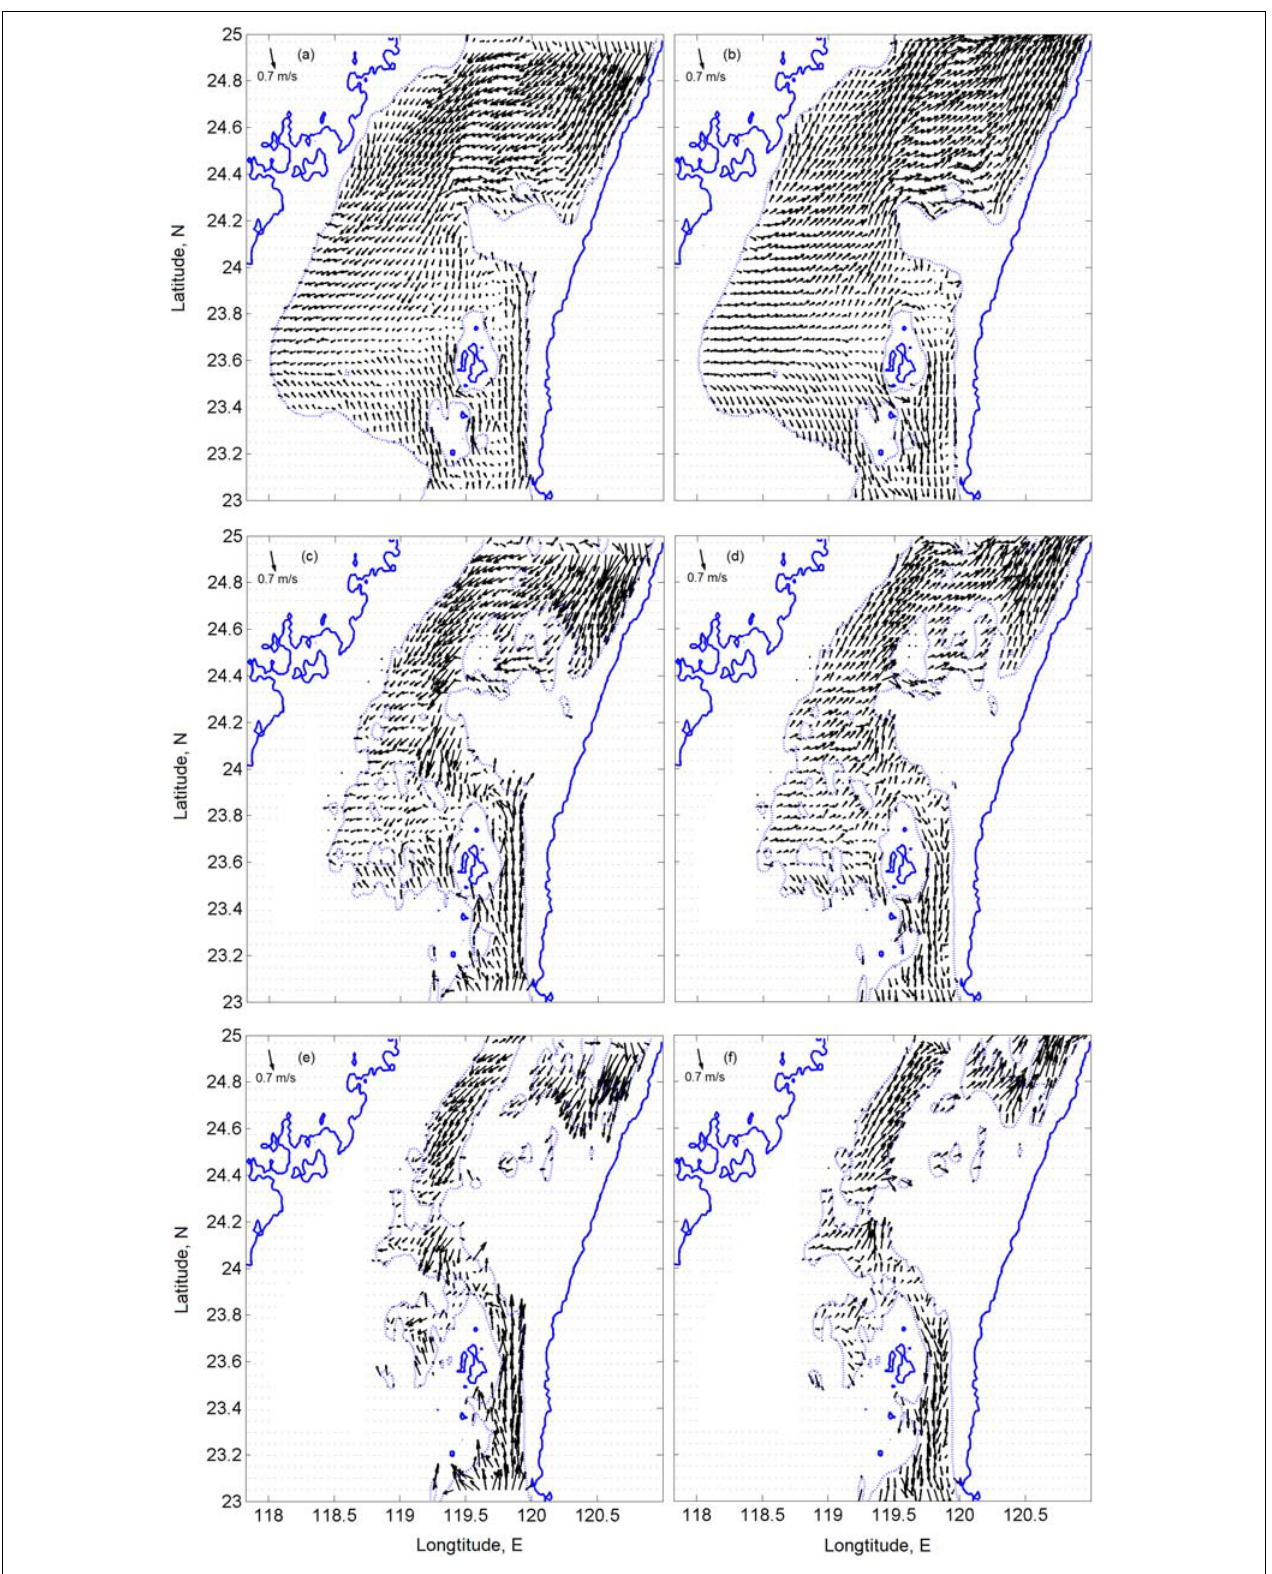
FIGURE 6 | Tidal velocities at water depths of (a,b) 30 m, (c,d) 50 m, and (e,f) 60 m below the surface at peak velocities on the flood (at the left panel) and ebb (at the right panel). The dotted lines delineate the corresponding depths.